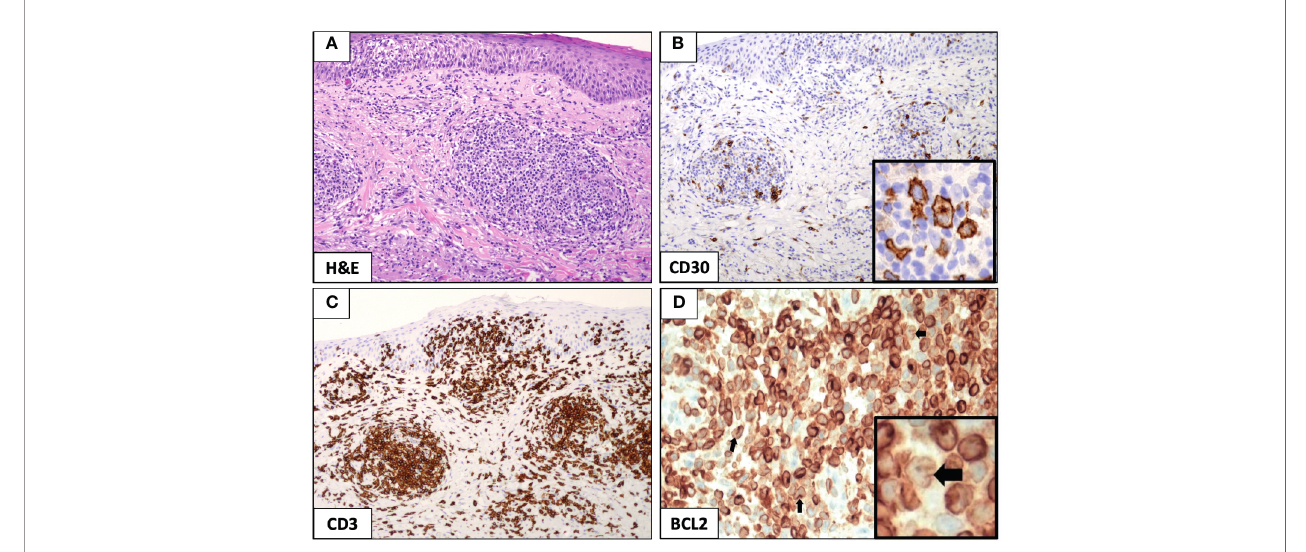
FIGURE 2 | Immunohistochemical analysis of mixed-in fi ltrate type A lymphomatoid papulosis (LyP). The punch biopsy from the left arm identi fi ed a diffuse in fi ltration of small lymphocytes and few large-sized Hodgkin-like cells that were prevalent in the dermis and subcutis, while largely sparing the epidermis ( A , original magni fi cation , ×10). Hodgkin-like cells stained positive for CD30 ( B , original magni fi cation , ×10; and B, inset, original magni fi cation , ×40) and were interspersed in a dense lymphoid in fi ltrate mostly contributed by CD3 + T cells ( C , original magni fi cation , ×10). The expression of the anti-apoptotic protein BCL2 was strong and pervasive in the LyP tissue ( D , original magni fi cation , ×10), and it was readily recognized in the reactive lymphoid meshwork and large-sized Hodgkin-like cells ( D , inset, black arrow, original magni fi cation ,